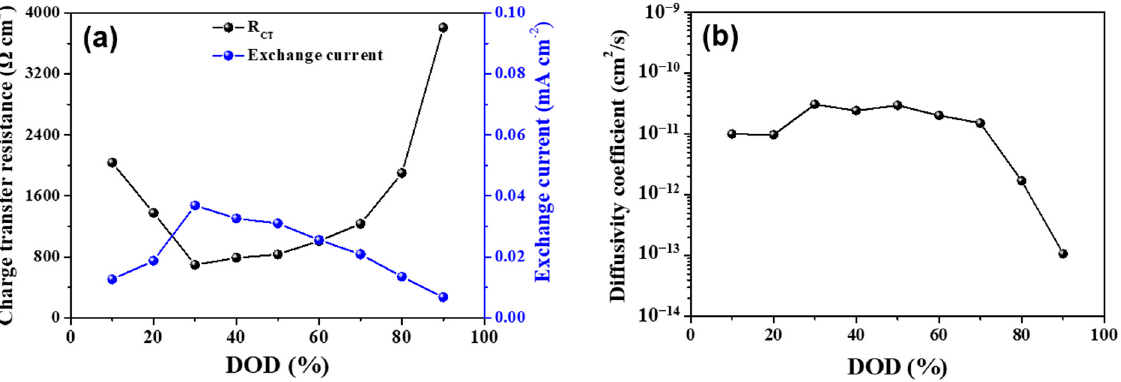
Figure 5. ( a ) The variation in electrochemical parameters (i) charge transfer resistance, (ii) exchange current, and ( b ) di ff usion coe ffi cient with the Li ion transformation during the discharge process. Table 1. The comparative electrochemical properties of previously reported results of NCM elec- trodes and current results of NCM particles using cavity electrode by pulse method.